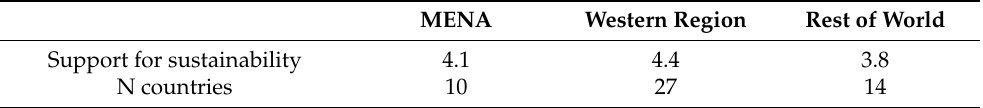
Table 8. Support from business and government for sustainability in MENA, western region, and the rest of the world (51